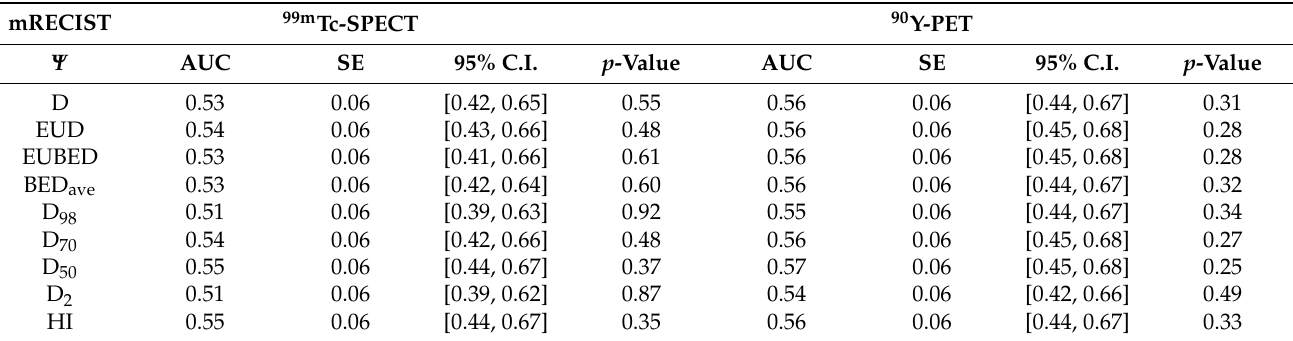
Figure 4. The AUC values of the ROC for 99m Tc-SPECT and 90 Y-PET returned with the densitometric method. Table 7. AUC values obtained with mRECIST. No p -value reached statistical significance.